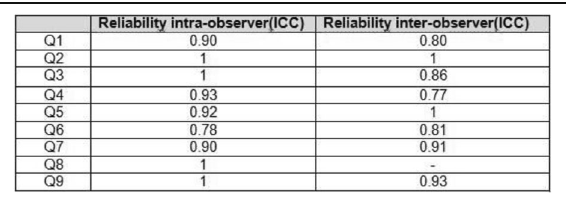
Table 1 (abstract P134). ICC for inter and intra-observer